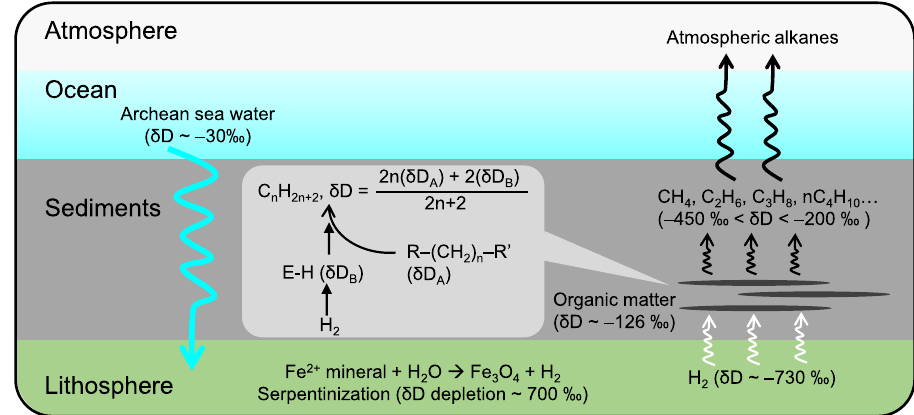
Fig. 5 Conceptual model. The model is showing hydrogen isotope fractionation during alkane generation from the biodegradation of organic matter with serpentinization-derived hydrogen in the Neoarchaean